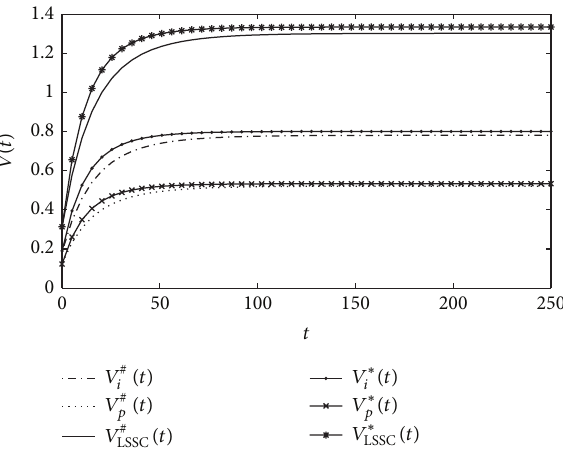
Figure 4: Change of profits of LSSC and the members after adopting cost sharing